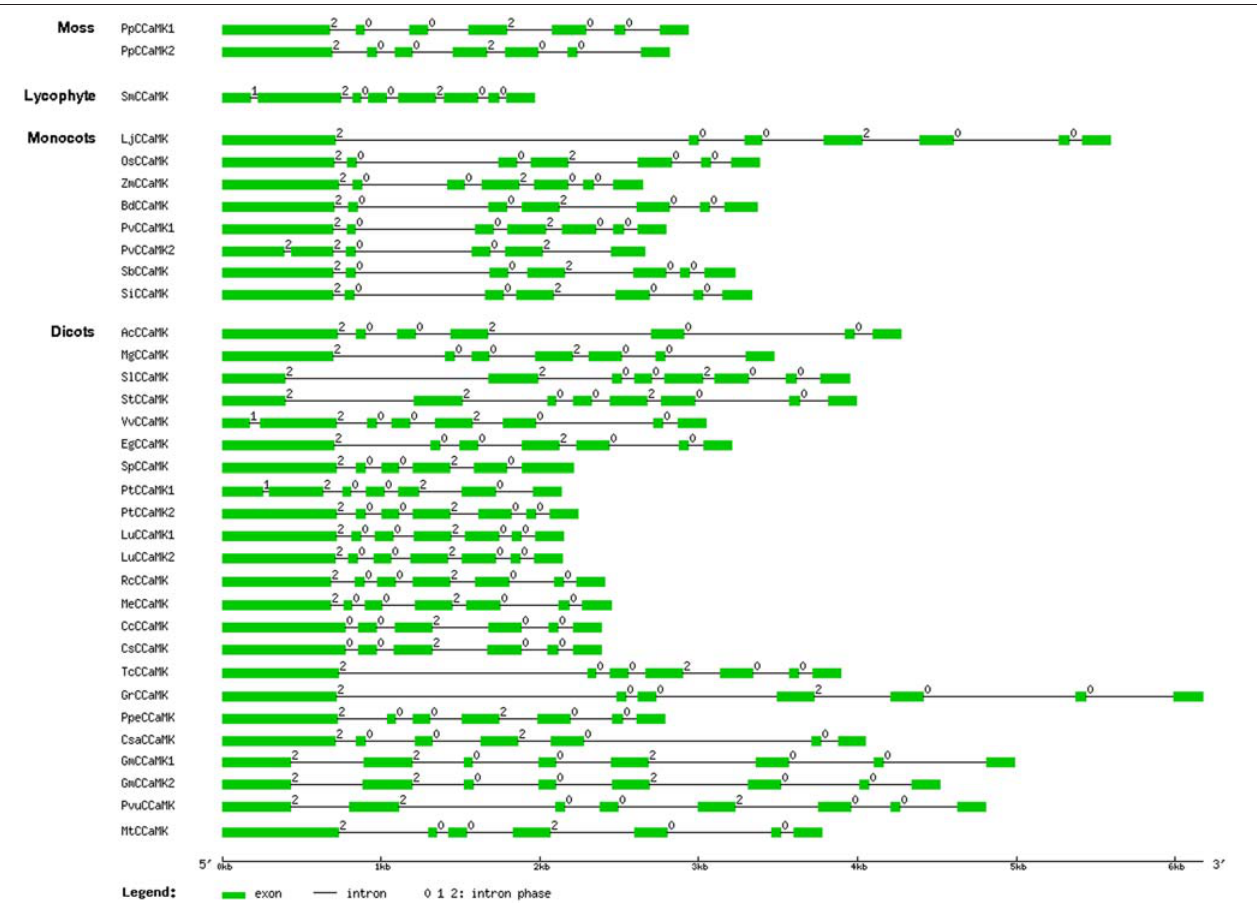
FIGURE 4 | Schematic diagram indicating the exon/intron structure of the CCaMK genes. The locus number of the 34 CCaMK genes was listed in Table S1. Exons and introns are indicated as green boxes and black lines, respectively. The intron phase number 0, 1, and 2 are labeled at the beginning of each intron. The diagram is drawn to